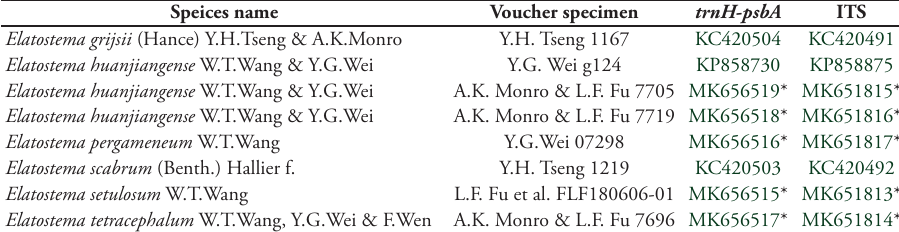
Table 1. Species name, voucher specimen and accession numbers of trnH - psbA and ITS used in this study (*denoted newly generated